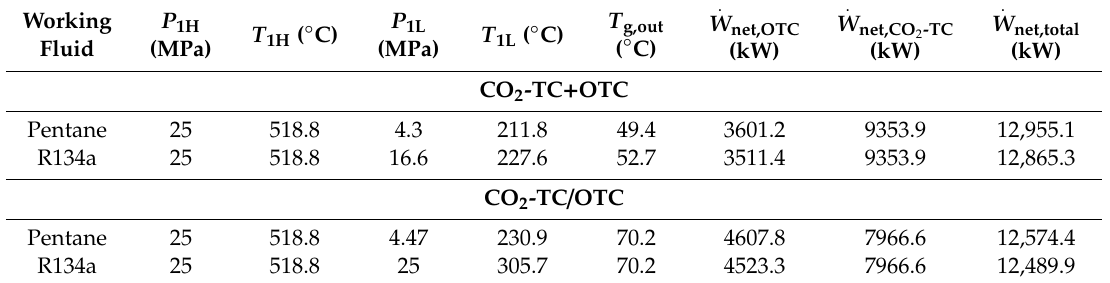
Figure 9. T-Q diagram of exhaust gas and working fluid for CO 2 -TC + OTC ( a ) R134a, ( b ) Pentane. Table 5. Optimized variables and cycle performance of two combined cycles.